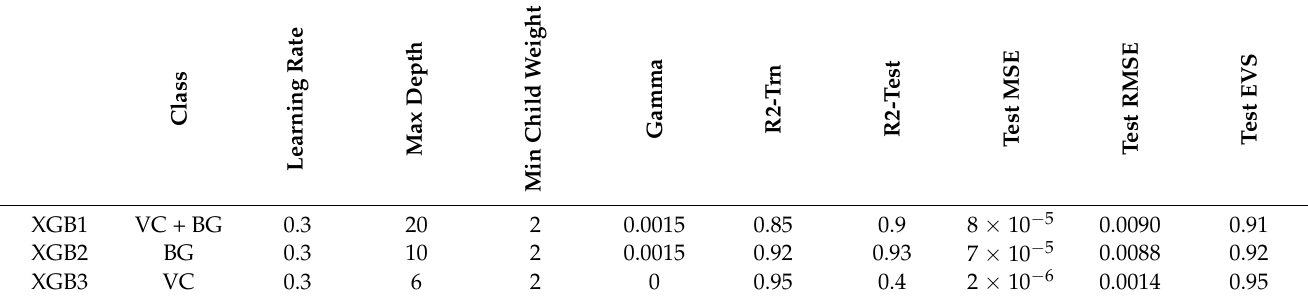
* Table Legend: Learning Rate (0~infinity), Max Depth (0~infinity), Loss Function (Gamma), Train Score (R2- trn), Test Score (R2-test), Root Mean Square Error (RMSE), Explained Variance Regression Score (EVS), Extreme Gradient Boosting (XGB), Vegetation Covered (VC), and Bare Ground (BG). The line plot and scatter plot of measured volumetric soil moisture content ( θ ) versus predicted ( θ ’) by the SVR1 model are presented in Figure 14.